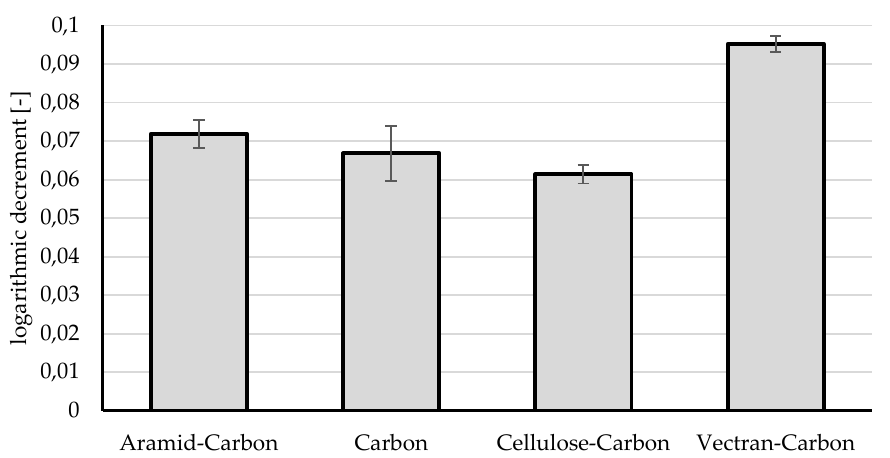
Figure 9. Logarithmic decrement with the same spring stiffness.